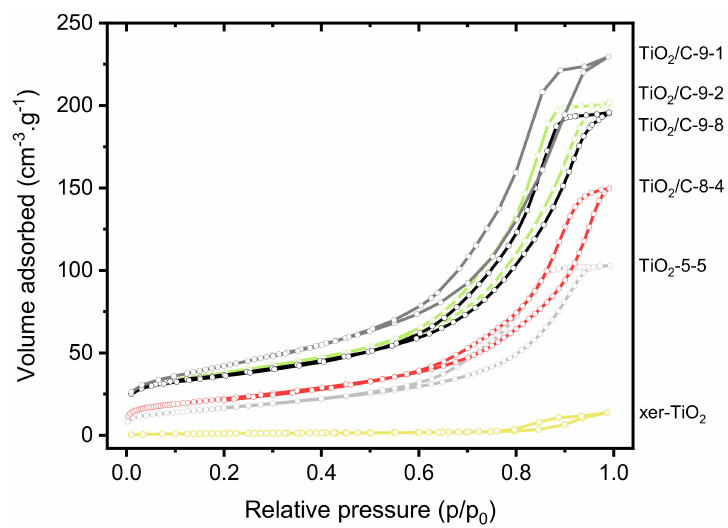
Figure 5. Nitrogen sorption isotherms at 77 K of xer-TiO 2 , TiO 2 -5-5 and the di ff erent TiO 2 / C- x - y samples prepared herein.